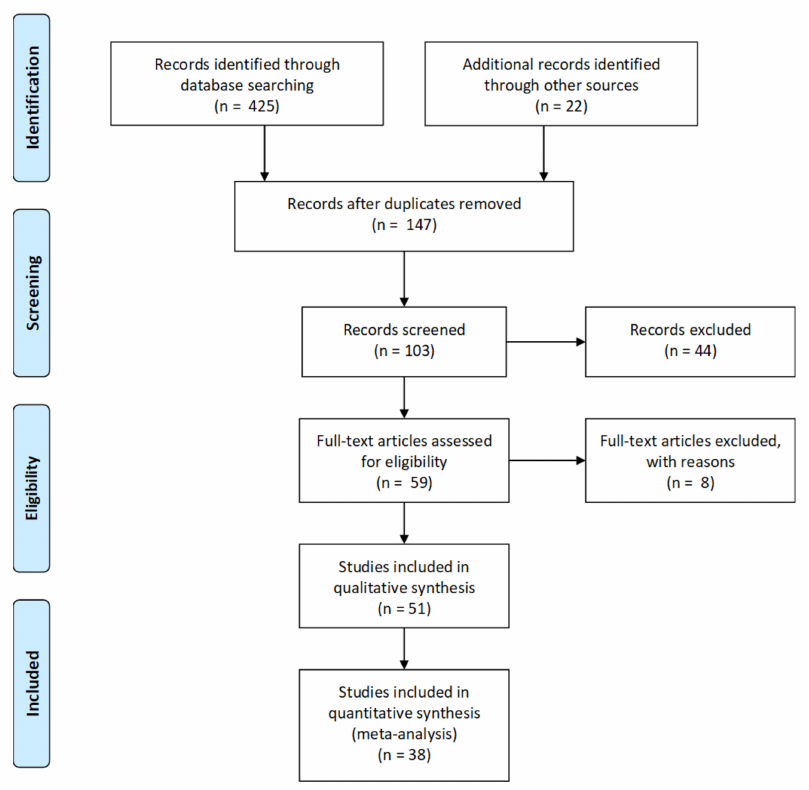
Figure 4. Flow diagram of the study-selection process used for the meta-analysis of Ng and